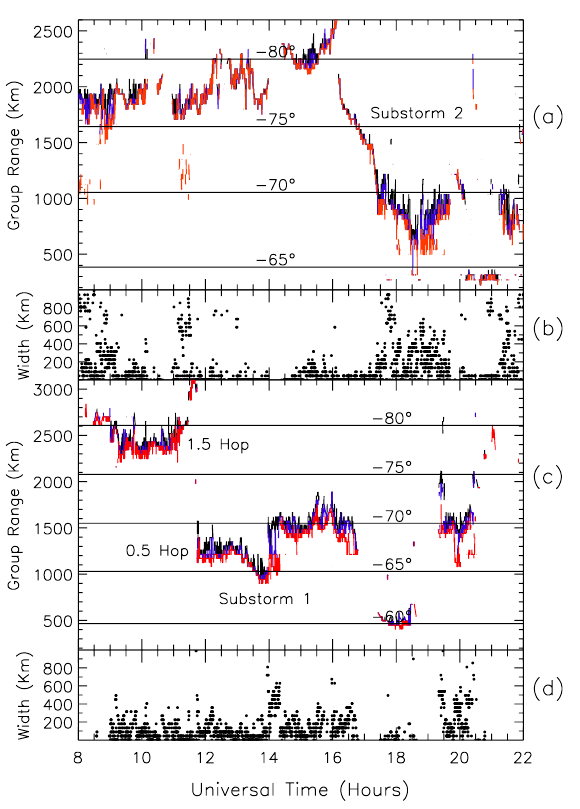
Fig. 4. Range-time plots of the radar spectral width boundaries (SWBs) identified on (a) Halley beam 8 and (c) TIGER beam 4 dur- ing 08:00 to 22:00 UT, 1 April 2000. The SWBs are shown for three different values of the spectral width threshold, namely 50ms − 1 (red), 100ms − 1 (blue), and 150ms − 1 (black). The thin horizontal lines represent magnetic latitudes between − 60 ◦ and − 80 ◦ . Cor- responding differences in the SWB locations using thresholds of 50ms − 1 and 150ms − 1 are shown in parts (b) and (d)